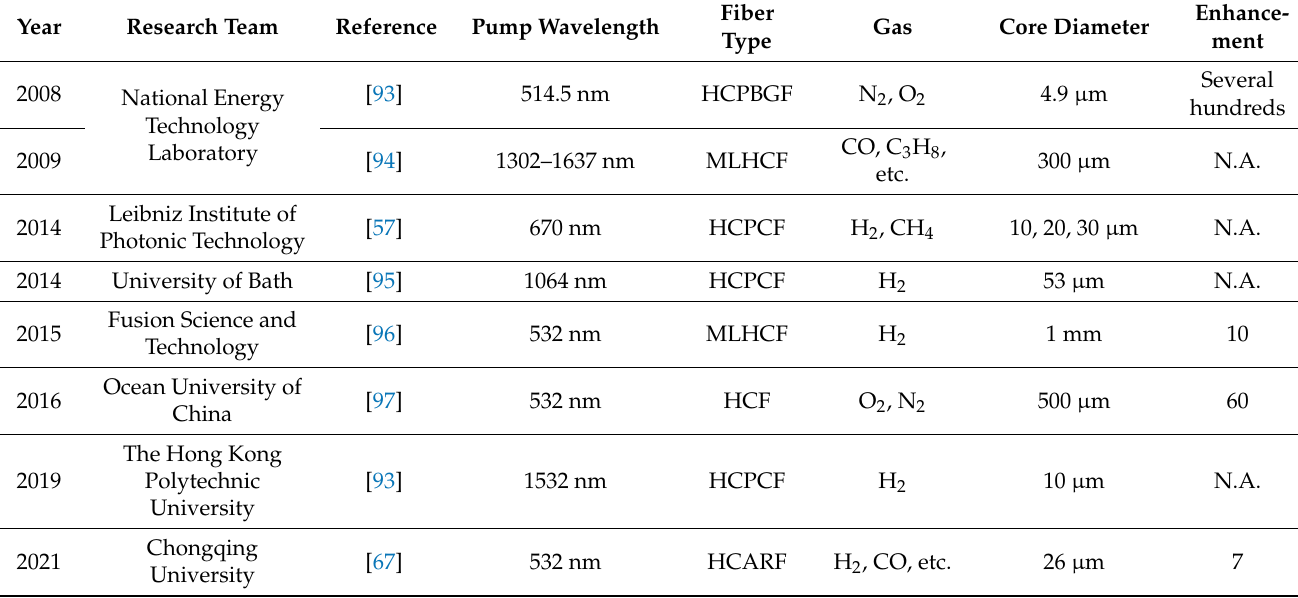
Table 3. Examples of gas Raman spectroscopy with